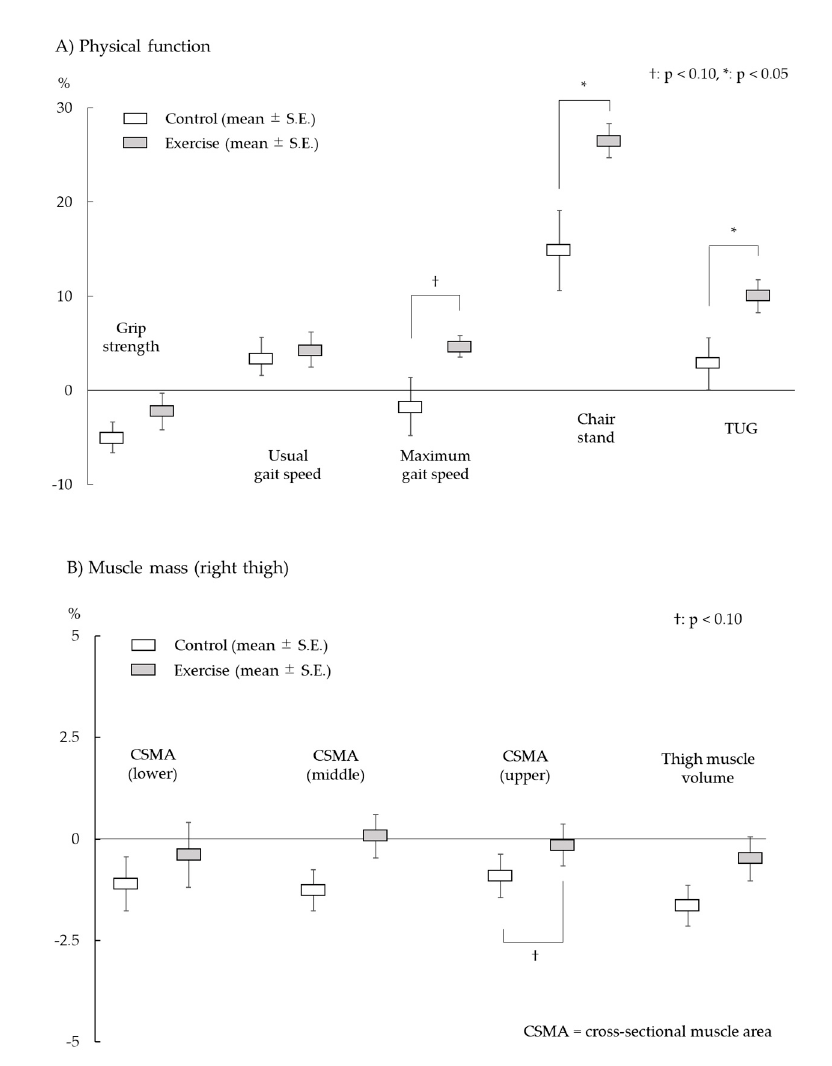
Figure 3. Improvement percentage of sarcopenia-related physical function and muscle mass after intervention.